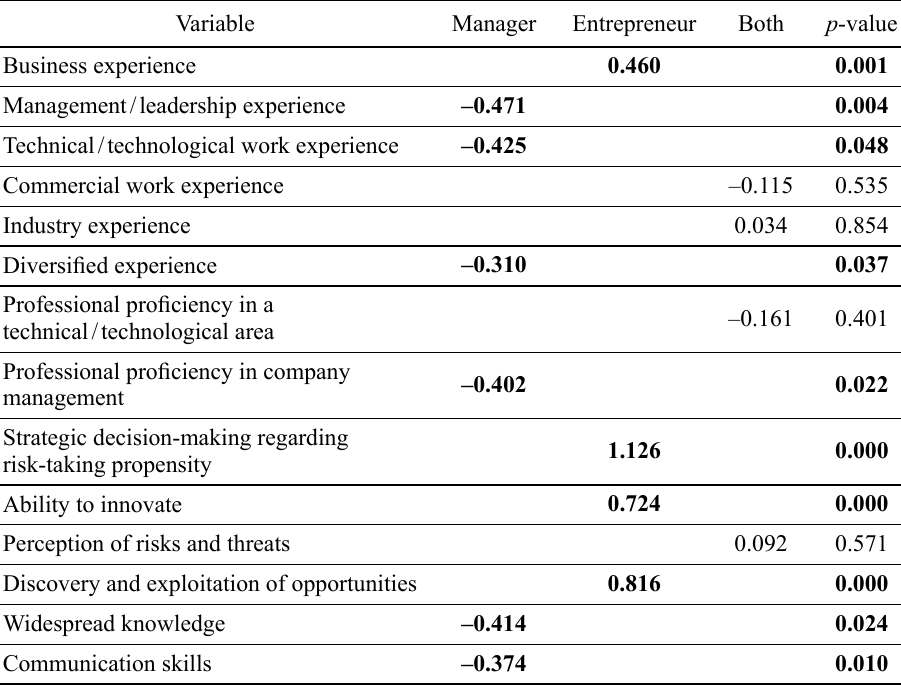
Table 2. Test of significance for the differences between “Manager” and